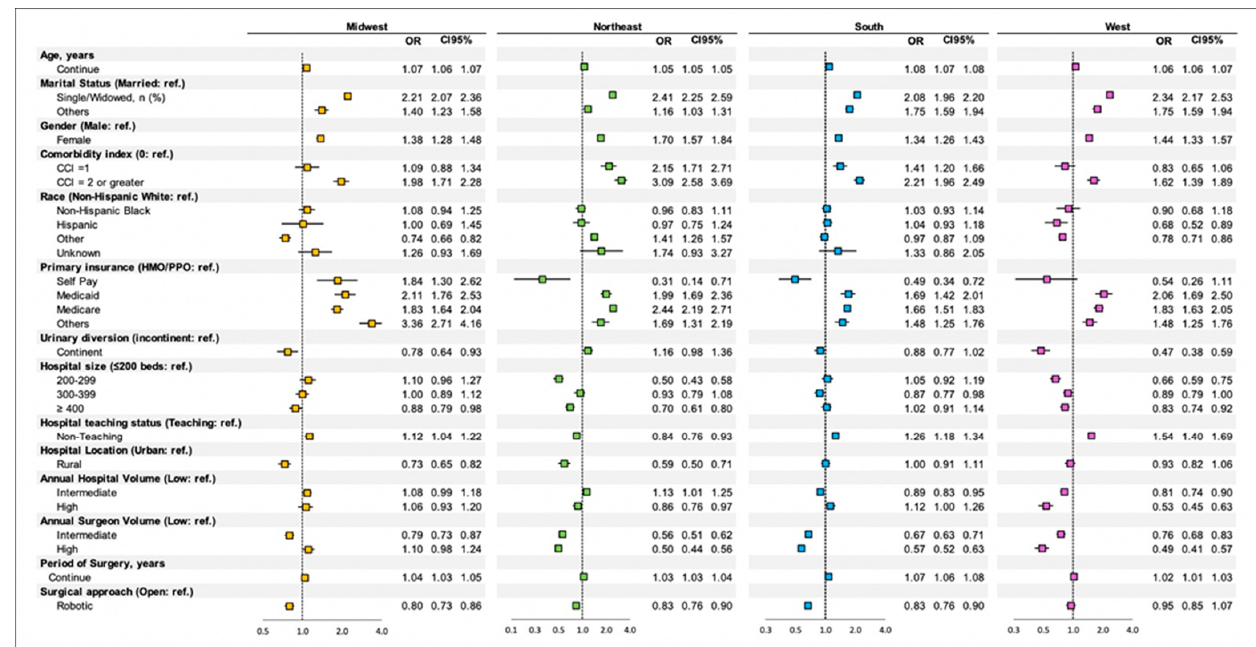
Figure 3. Multivariable Analysis—Geographical Subsets. OR: Odds Ratio.